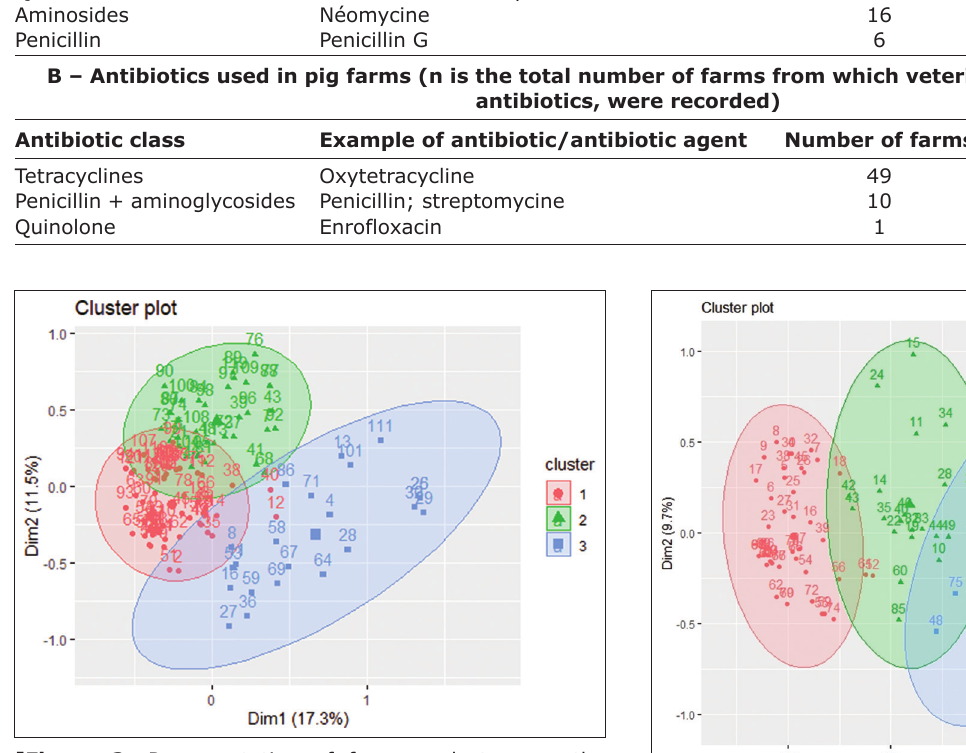
[Figure 2: Representation of farmers clusters on the factorial axes 1 and 2 in poultry farms; the numbers correspond to the breeders]. [Figure 3: Representation of farmers clusters on the